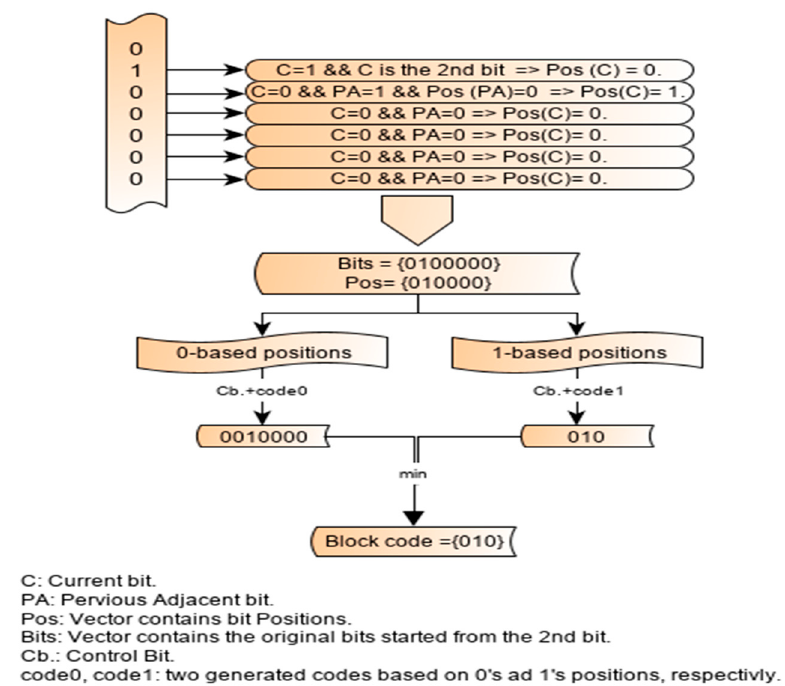
Figure 5. Workflow of the encoding process of the first block using the SEB scheme.